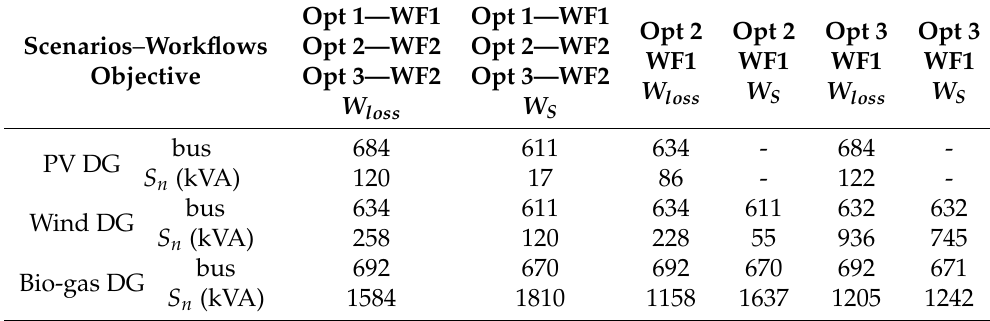
Table 9. Results comparison for optimization models and workflows in case of single-objective